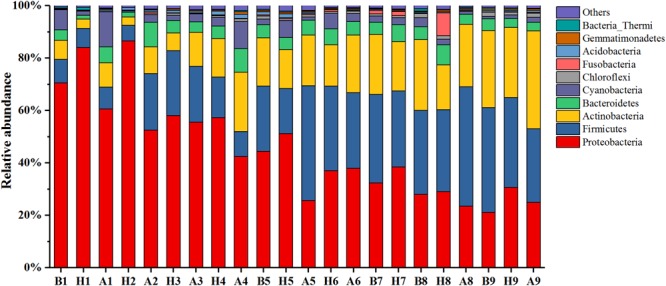
Bacterial community compositions at the phyla level during Nos. 1–9 haze events. Only the top 10 most abundant phyla are presented. The category “others” contains all the remaining bacterial phyla. “H” represents haze pollution samples, while “B” and “A” represent the non-haze samples collected “before” or “after” occurrence of haze.